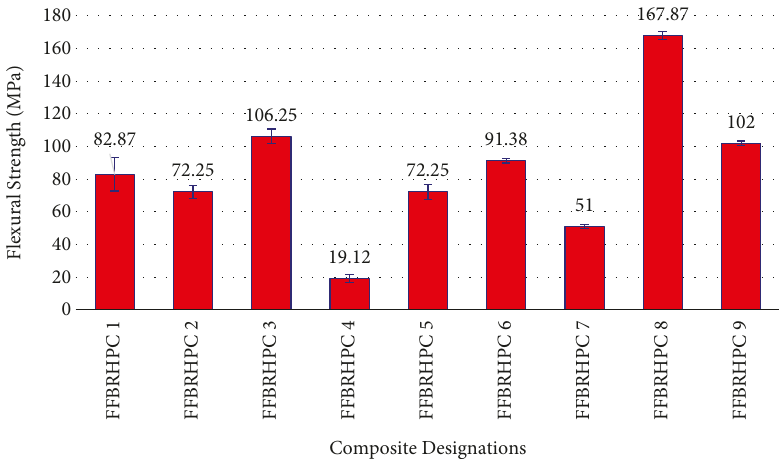
Figure 4: Comparison of average flexural strength of fabricated